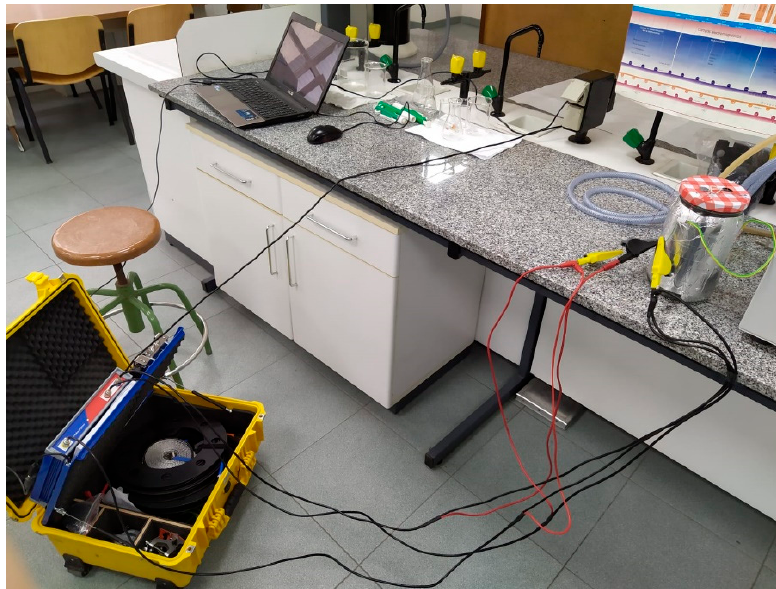
Figure 11. FRA test connections to the two-liter container. No thermostable bath was done in this test.